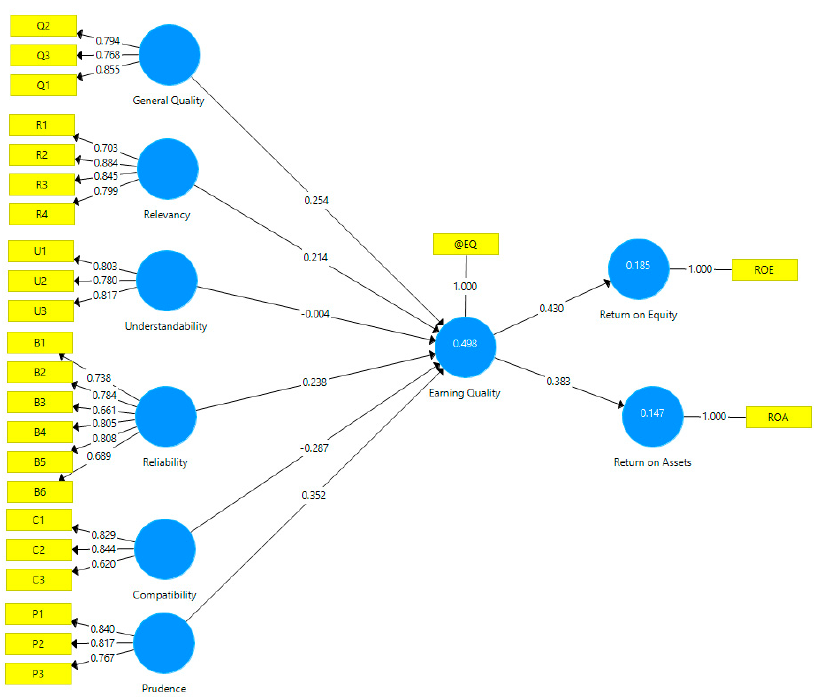
Figure 3. Research Model with Outer Loads and Beta. Source: Developed by the author based on software results.